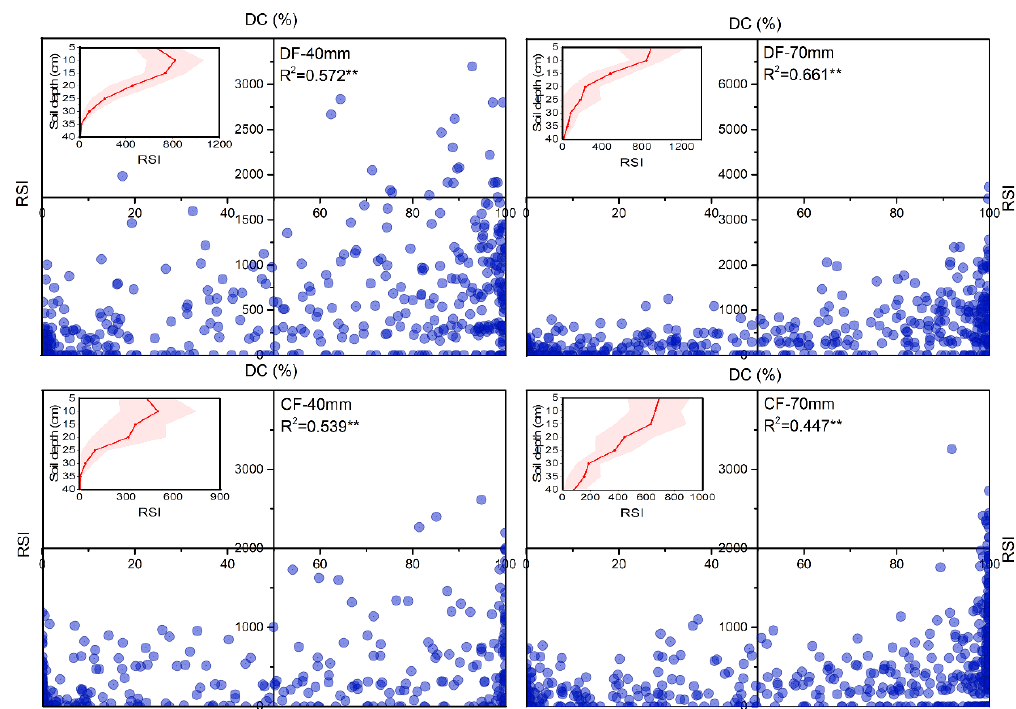
Figure 5. Features of root-solute interaction ( RSI ) in DF and CF soils. DF-40 and CF-40 mm are large rainfall event (40 mm). DF-70 and CF-70 mm are for extreme rainfall (70 mm). DF: deciduous forest; CF: coniferous forest.